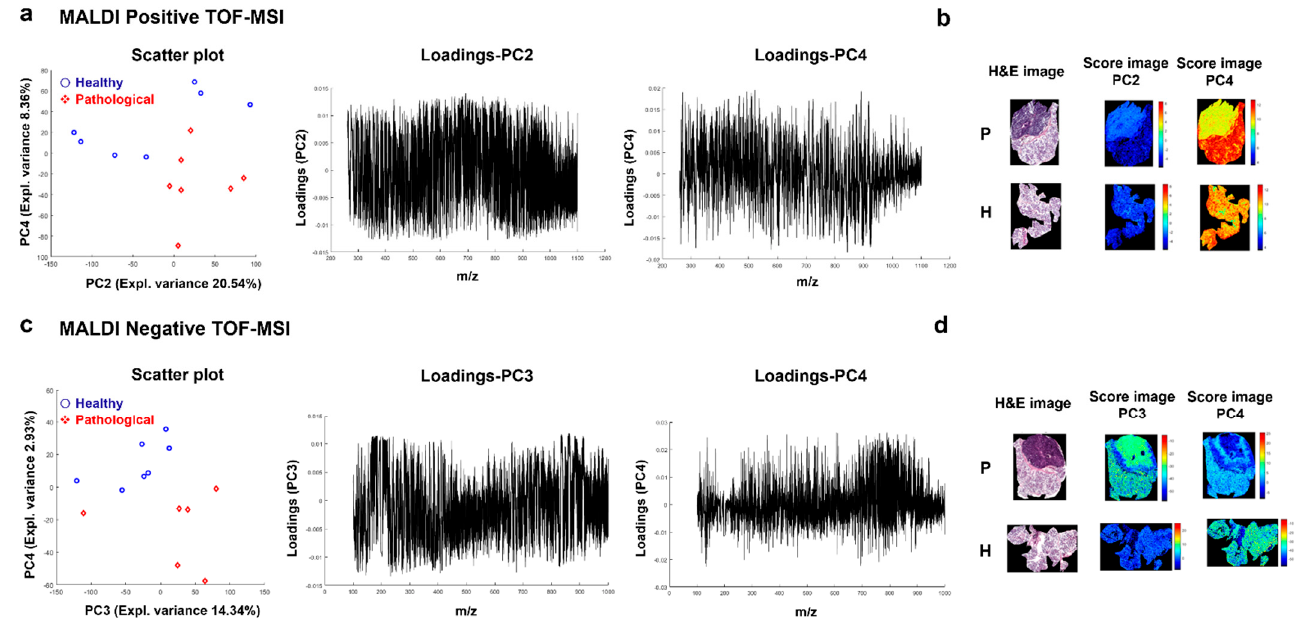
Figure 1. Principal component analysis (PCA) results of MALDI-positive and -negative TOF-MSI data analysis. ( a ) PC2 vs. PC4 scores with loadings plots and ( b ) PC2 and PC4 score images for patient 3 compared with the histological image for the positive ion mode MSI dataset. ( c ) PC3 vs. PC4 scores with loadings plots and ( d ) PC3 and PC4 score images for patient 3 compared with the histological image for the negative ion mode MSI dataset. PCA was performed using pre-processed spectra from the training set. Loadings obtained from PCA were applied to the images of the training set. Abbreviations: H&E, Hematoxylin and Eosin staining; P, pathological tissue; H, healthy